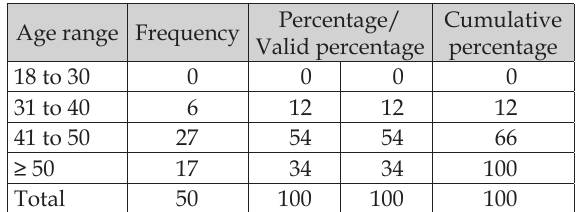
Table 7. The result of Mann-Whitney